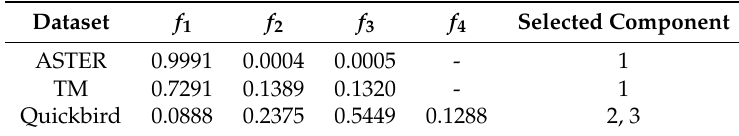
Figure 9. Four PCA components of the QuickBird difference image and the selected PCs of TM and ASTER data. ( a ) the first PC for QuickBird images, f 1 = 0.0888; ( b ) the second PC, f 2 = 0.2375; ( c ) the third PC, f 3 = 0.5449; ( d ) the fourth PC, f 4 = 0.1288; ( e ) the selected component for TM images, f selected = 0.7291 ; and ( f ) the selected component for ASTER images, f selected = 0.9991. Table 1. Normalized component selection index for three